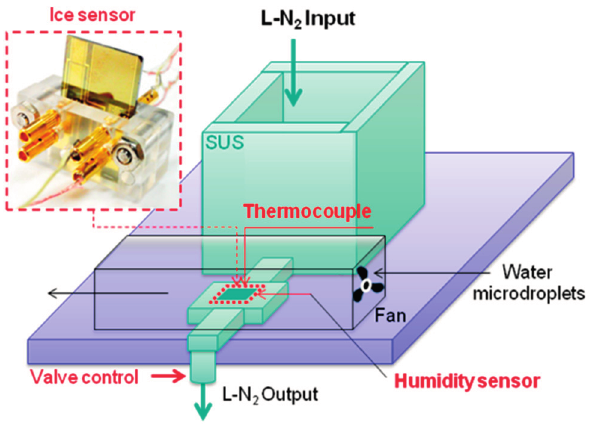
Figure 5. Cooling chamber to control temperature and